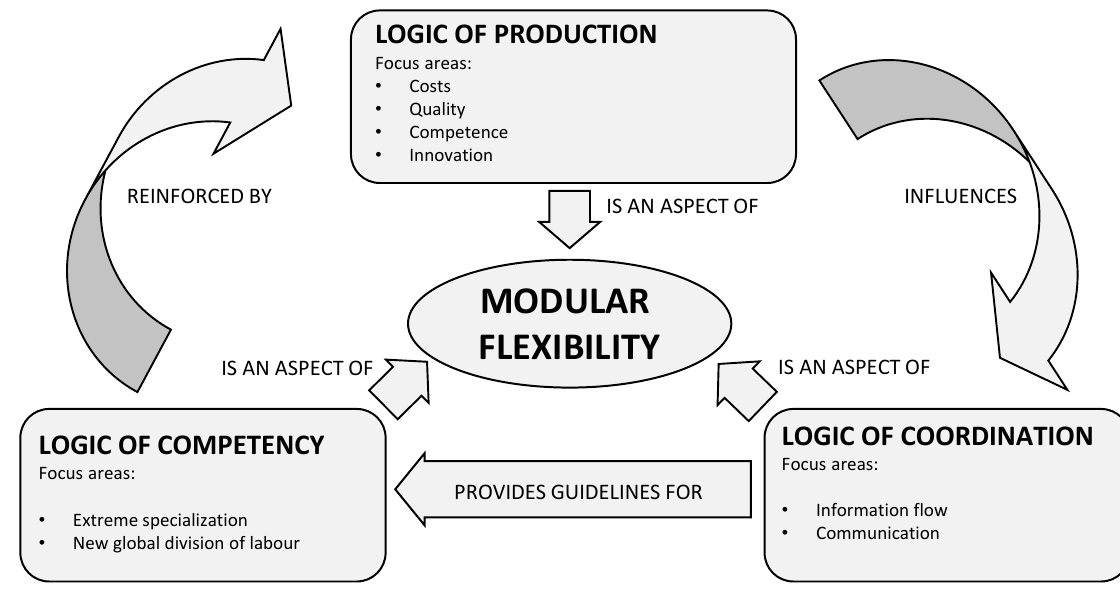
Figure 4. Modular